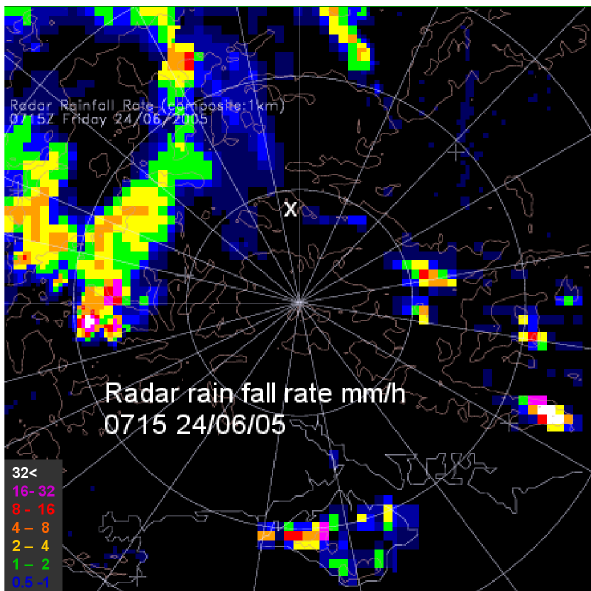
Fig. 3b. Composite weather radar rainfall for the 24 June 2005 at 06:30UTC. The white cross indicate Linkenholt site. The rain rate/h is indicated by the colour scale on the bottom left. The bulls- eye is centred at the Chilbolton radar with the first and second cir- cles of radius 25 and 50km.